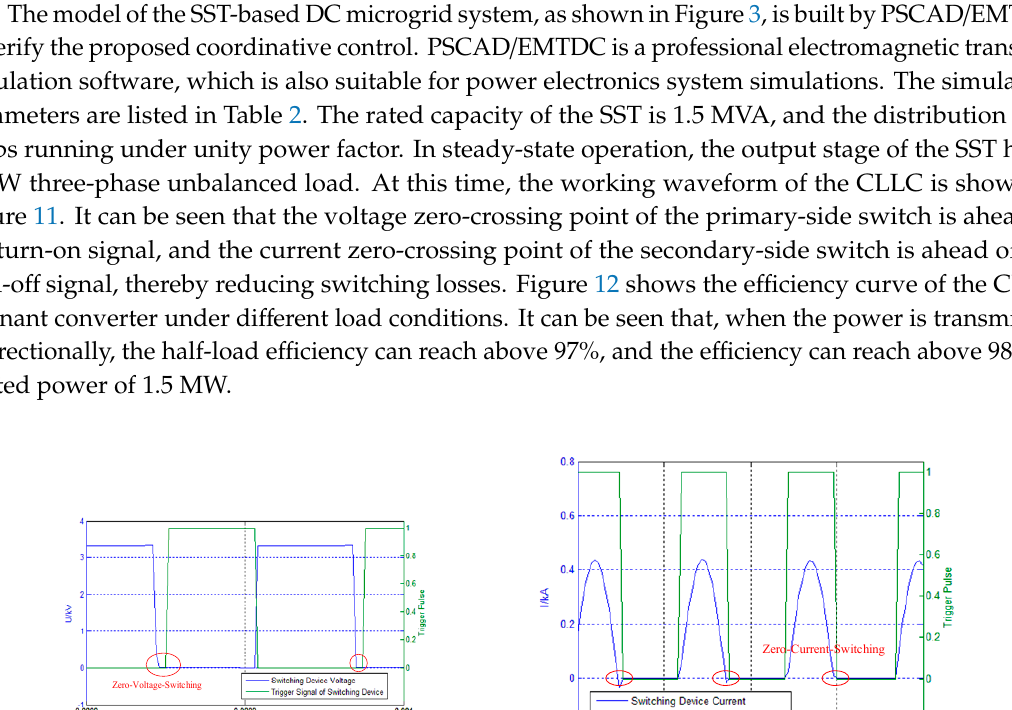
Figure 10. The voltage response Bode diagrams of the HVDC and LVDC links to the CLLC load current: ( a ) the LVDC bus voltage response; ( b ) the HVDC bus voltage response.